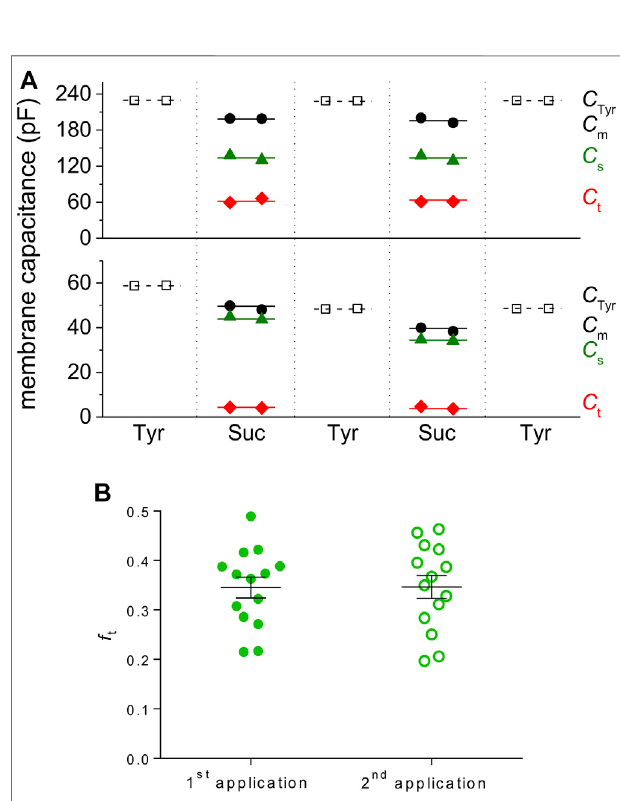
FIGURE 5 | Repeated sucrose application allows evaluation of t-tubular characteristics several times in a particular cell. (A) Representative examples of two sucrose applications in a row in ventricular (upper graph) and atrial (lower graph) cardiomyocytes. The perfusion time with sucrose solution did not exceed 50 s. (B) The evaluated f t was not different during subsequent sucrose applications (ventricular myocytes, n = 14, p > 0.05).